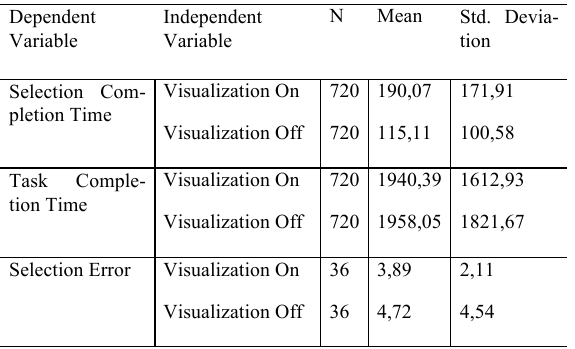
Descriptive statistics for Gestures With and Without Graphic